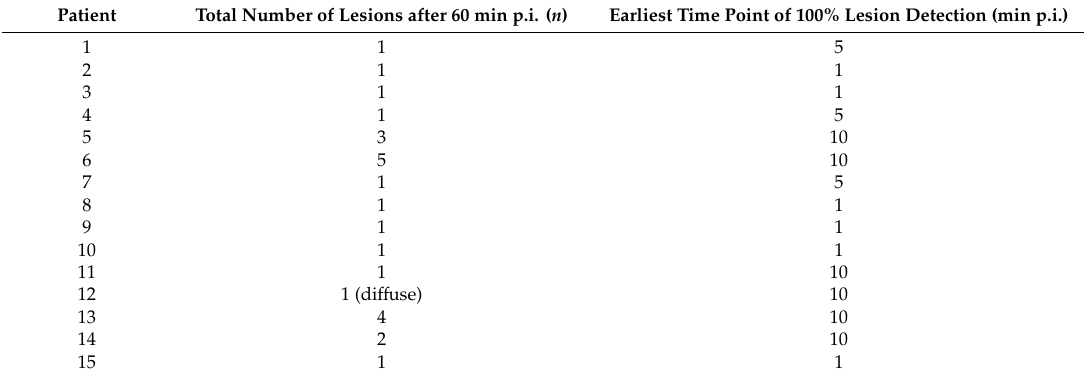
Table 1. Earliest time point of 100% lesion detection compared to the standard 60 min post tracer injection